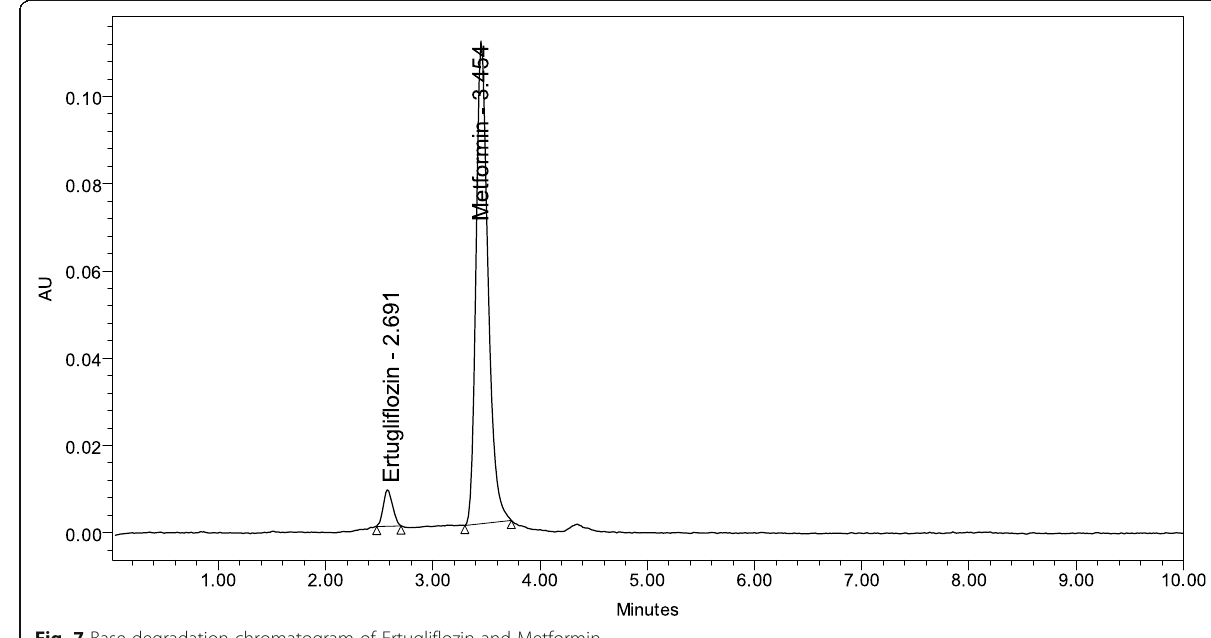
Fig. 7 Base degradation chromatogram of Ertugliflozin and